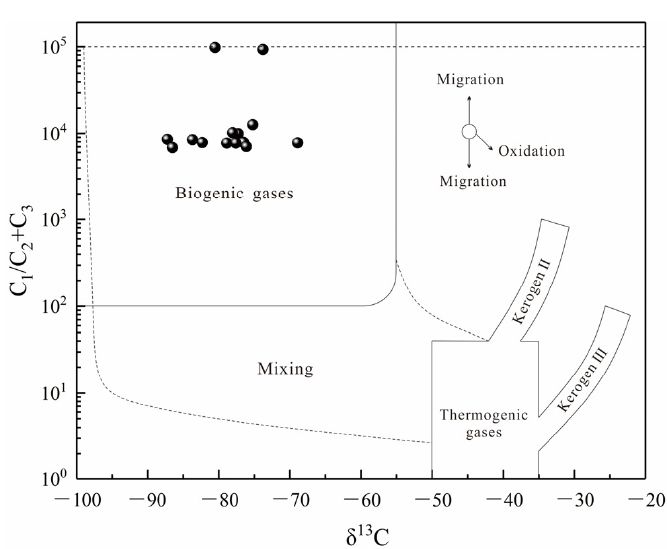
Figure 13. Identification chart of the genetic of CBM.